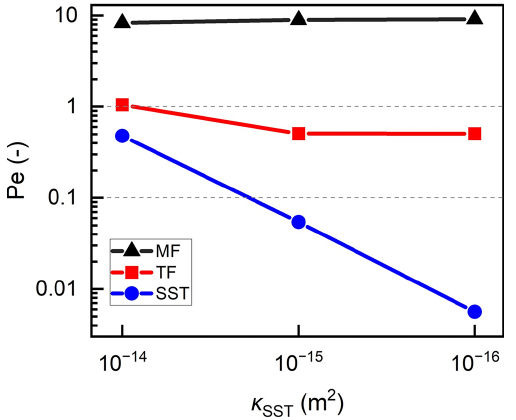
Figure 11. Effects of the anisotropic and depth-dependent perme- abilities of the main fault ( κ MF ) on the temperature-depth